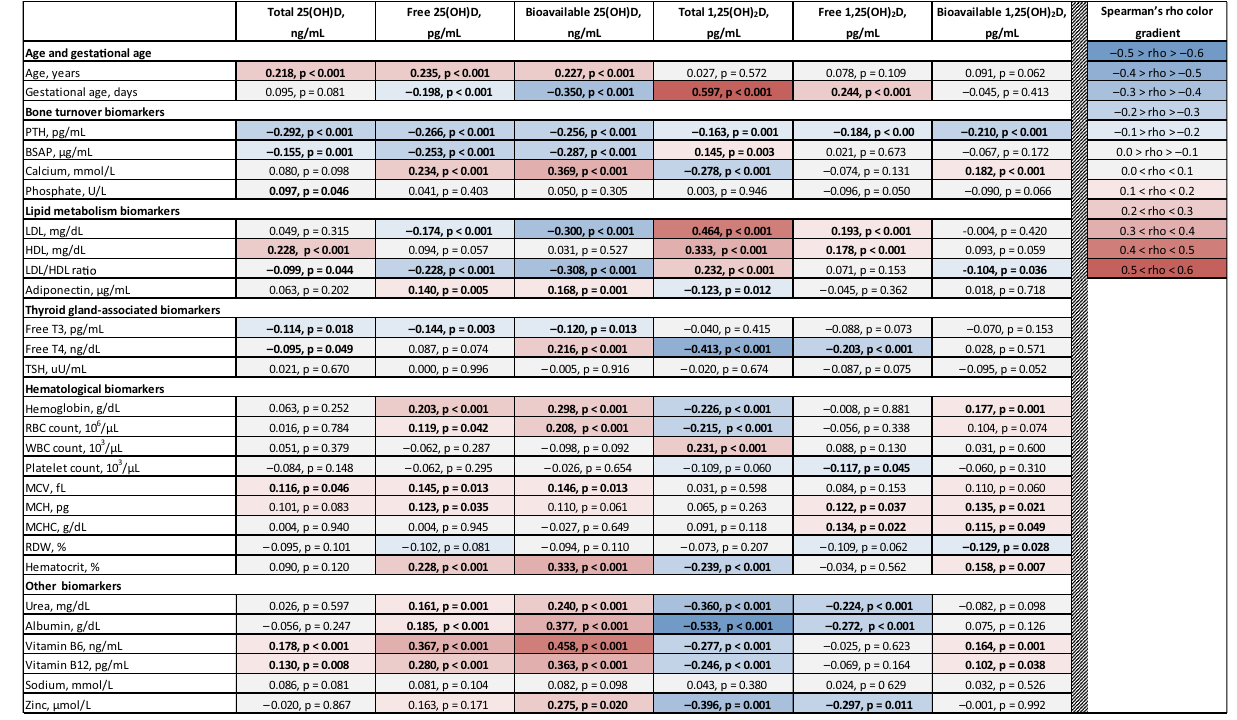
Table 3. Interrelations between 25OHD and 1,25(OH)and 1,25(OH) 2 D isoforms with age, gestational age, biochemical, hematological, and endocrinological serum parameters. The correlation strength is defined by Spearman’s rank correlation coefficient rho (appears first in each cell). Abbreviations: B25OHD, bioavailable 25OHD;